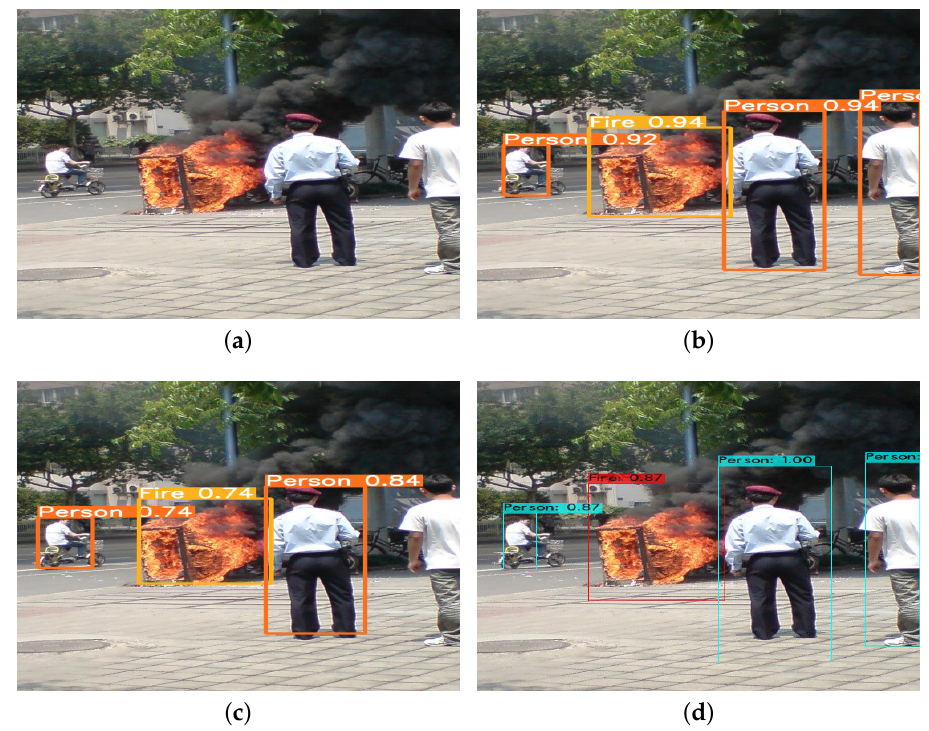
Figure 12. Example of fire detection effect. Among them, ( a ) shows the original figure; ( b ) shows the effect of our proposed improved YOLOv5s network detection; ( c ) shows the detection effect of YOLOv5s; ( d ) shows the detection effect of